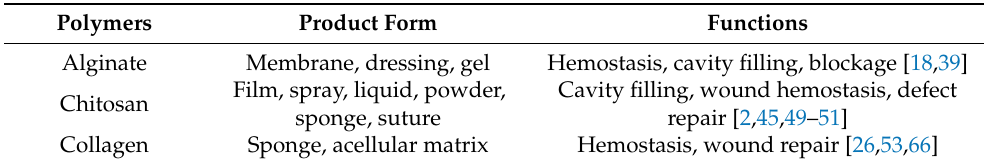
Table 5. Main product forms and functions of the three